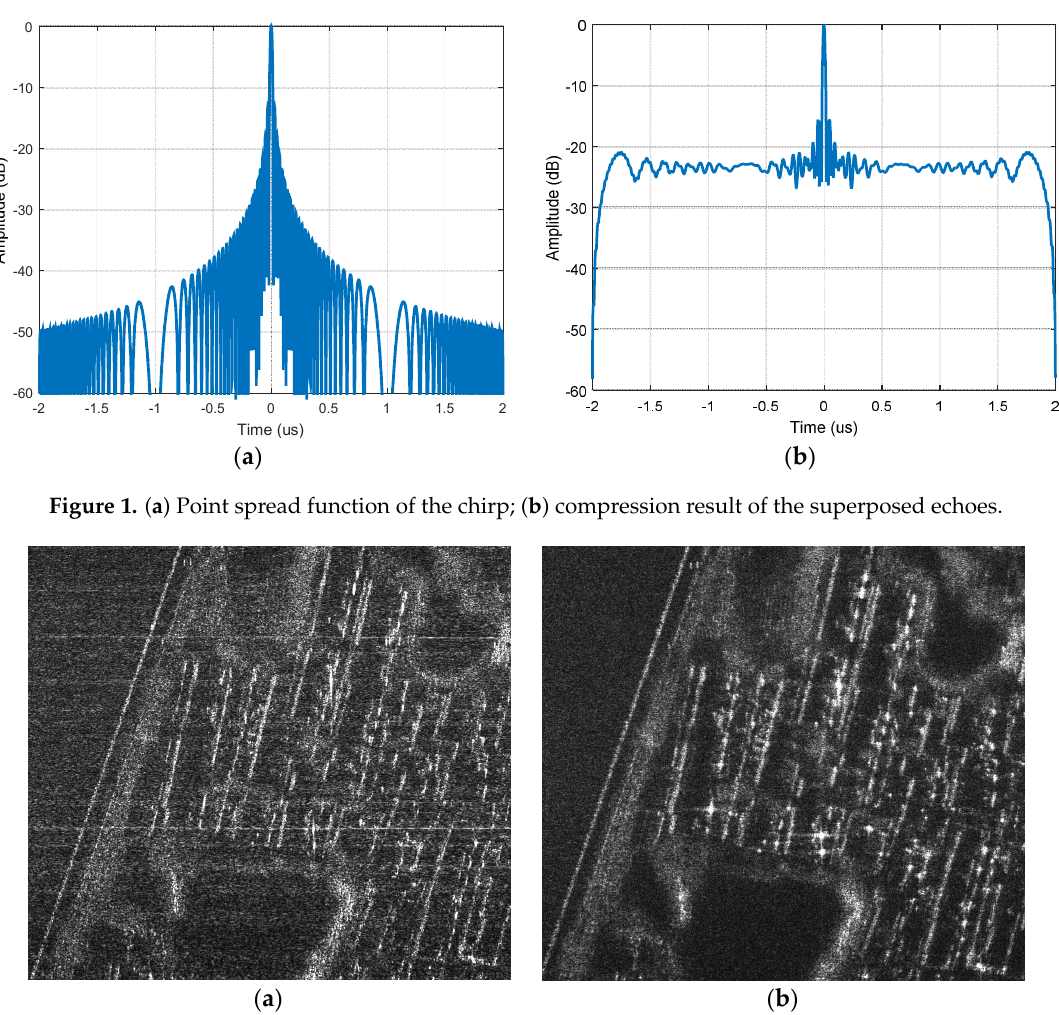
Figure 2. ( a ) MIMO-SAR image with the up and down chirps. ( b ) Referenced SAR image.